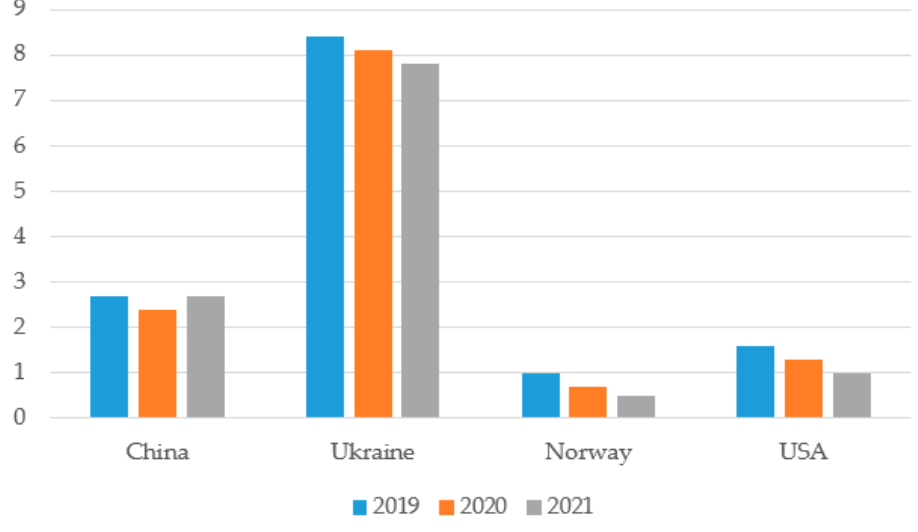
Figure 9. External interventions index (according to the data [18]).